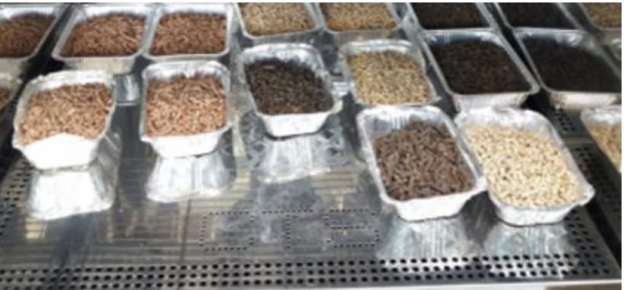
Figure 1. Pellets on aluminum trays in the climate chamber. This figure is an example showing the pellets on aluminum trays. The same trays were used for the other storage